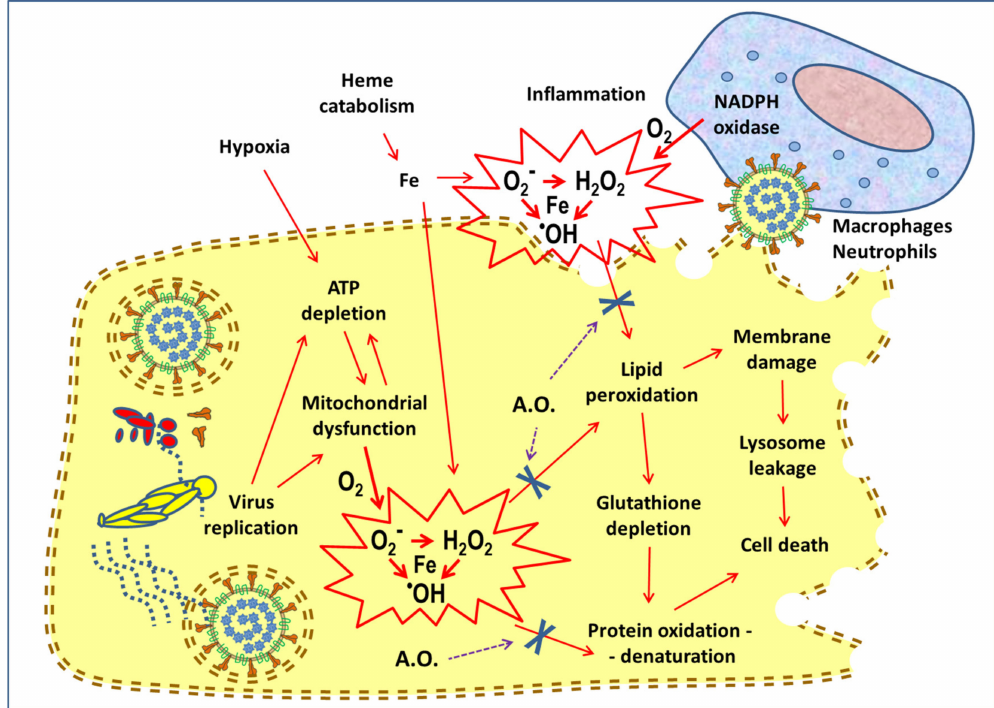
Figure 2. Schematic representation of the mechanisms of generation of oxygen free radicals in the course of Coronavirus disease 2019 (COVID-19), and assumptions about the antioxidant (A.O.) action sites, indicated with